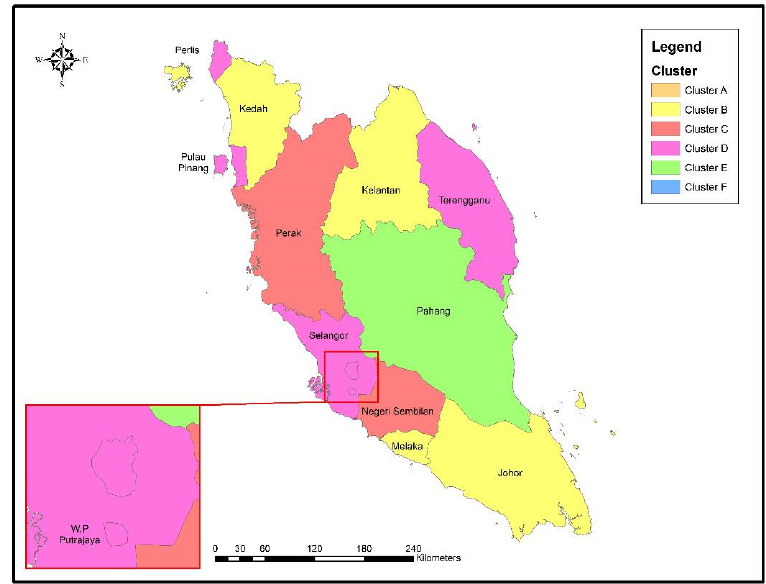
Figure 4. Types of clusters by states throughout Peninsular Malaysia.